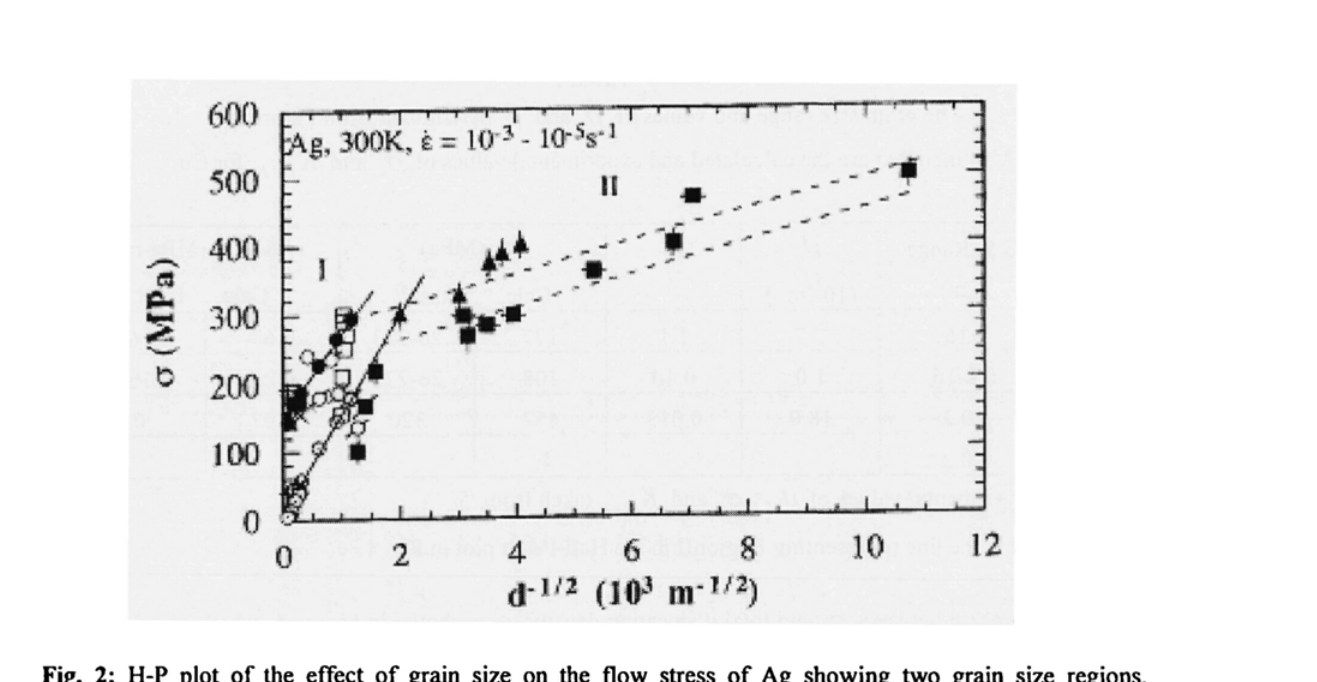
Fig. 2: H-P plot of the effect of grain size on the flow stress of Ag showing two grain size regions. From Conrad and Jung /4/